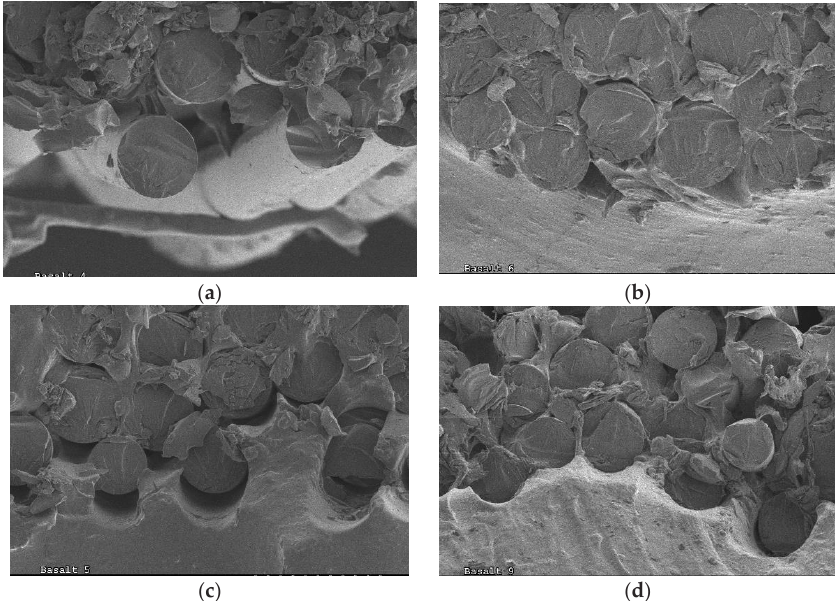
Figure 4. Cross-sectional images of basalt fibres: ( a ) un-sized/silicone-coated CR 173% (Basalt 4); ( b ) plasma-treated/silicone-treated CR 183% (Basalt 6); ( c ) un-sized/silicone-coated CR 261% (Basalt 5); ( b ) plasma-treated / silicone-treated CR 183% (Basalt 6); ( c ) un-sized / silicone-coated CR 261% (Basalt 5); ( d ) plasma-treated/silicone-coated CR 256% (Basalt 9). ( d ) plasma-treated / silicone-coated CR 256% (Basalt 9).